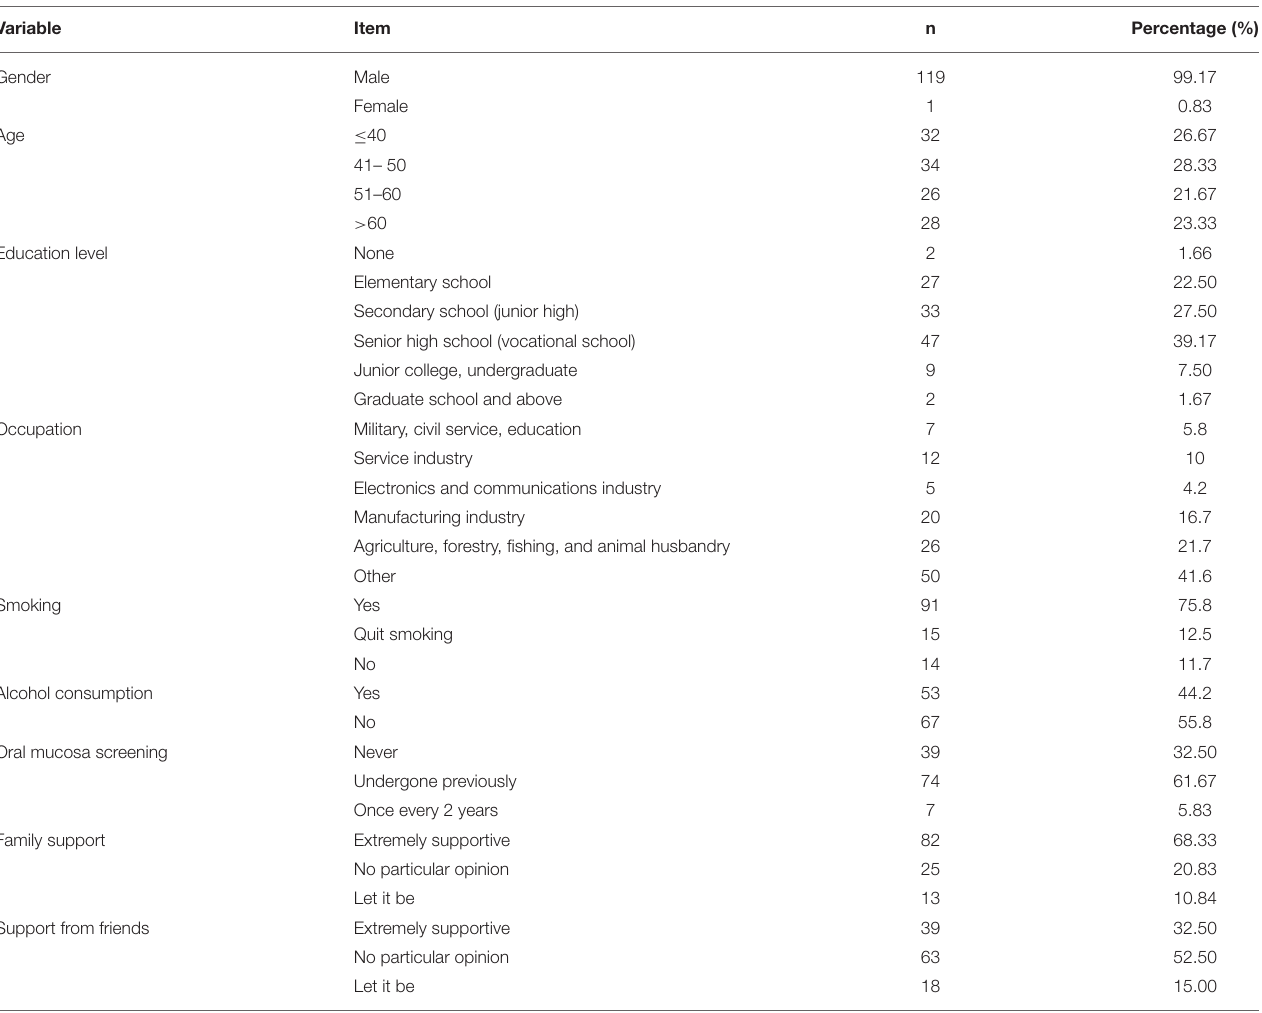
TABLE 1 | Basic information analysis ( n = 120).